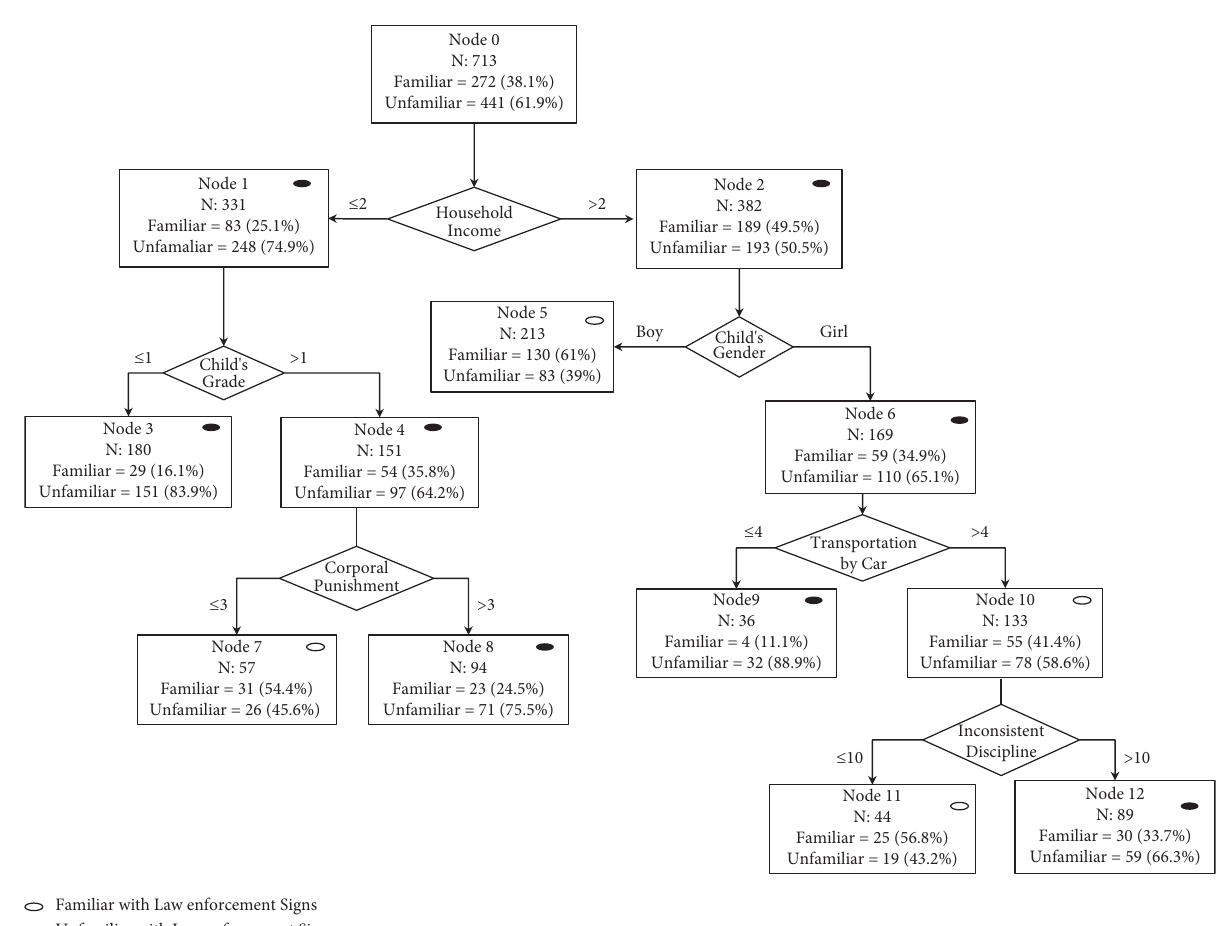
Figure 2: Decision tree of the law enforcement sign model (training